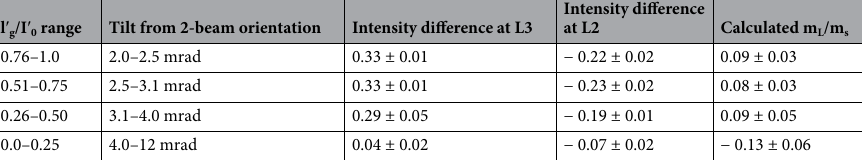
Table 1. The calculated values of m L /m S from the EMCD spectra obtained for different intervals of I ′ g /I ′ 0